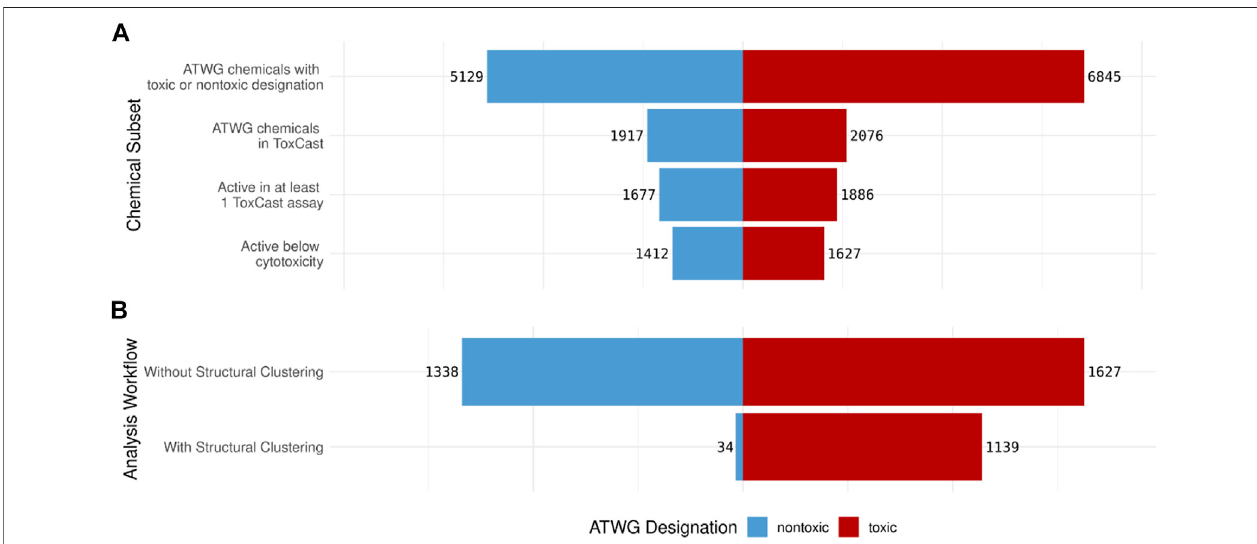
FIGURE2| Pyramidplotsshowing: (A) Thenumberofnontoxic(blue)andtoxic(red)ATWGchemicalsthatmeeteachcriterionand (B) Thenumberofnontoxicand toxic chemicals identi fi ed by the minimum ToxCast assays generated by the assay analysis work fl ow both without and with using the structural clustering information. The number ofnontoxicchemicals identi fi ed bytheminimumassaysisdrasticallyreducedwhentheclusteringinformationisused withonlyaslight loss inthenumberof toxic compounds.